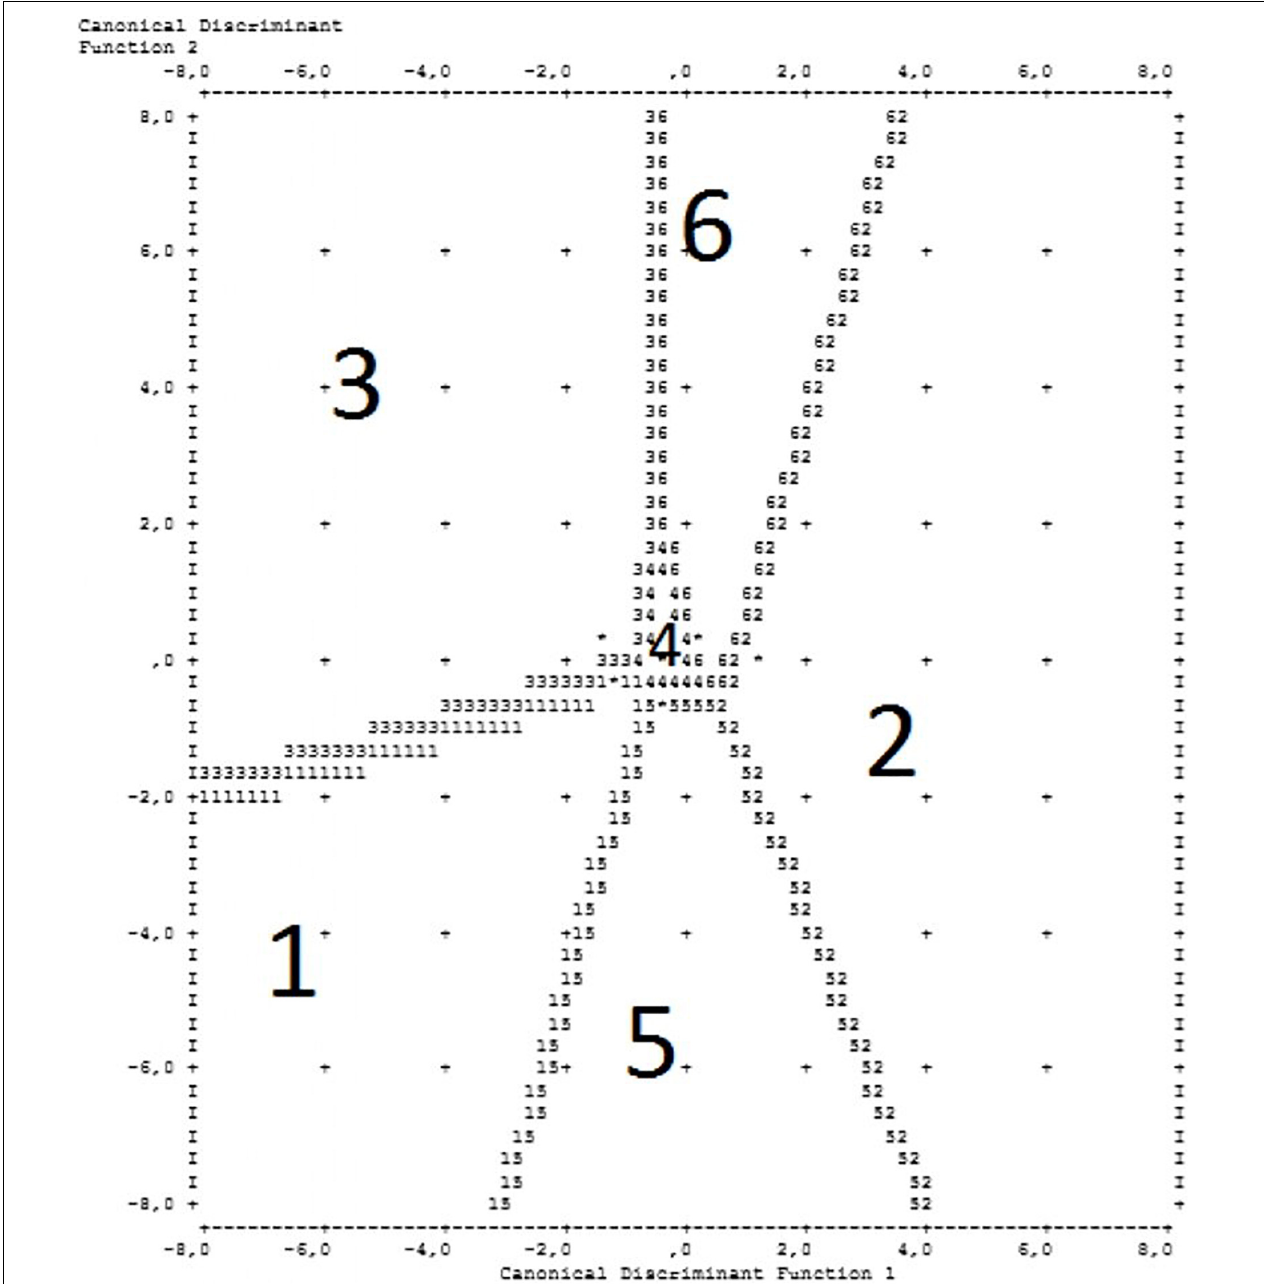
FIGURE 2 | Groups and groups’ centroid location on the discriminant functions